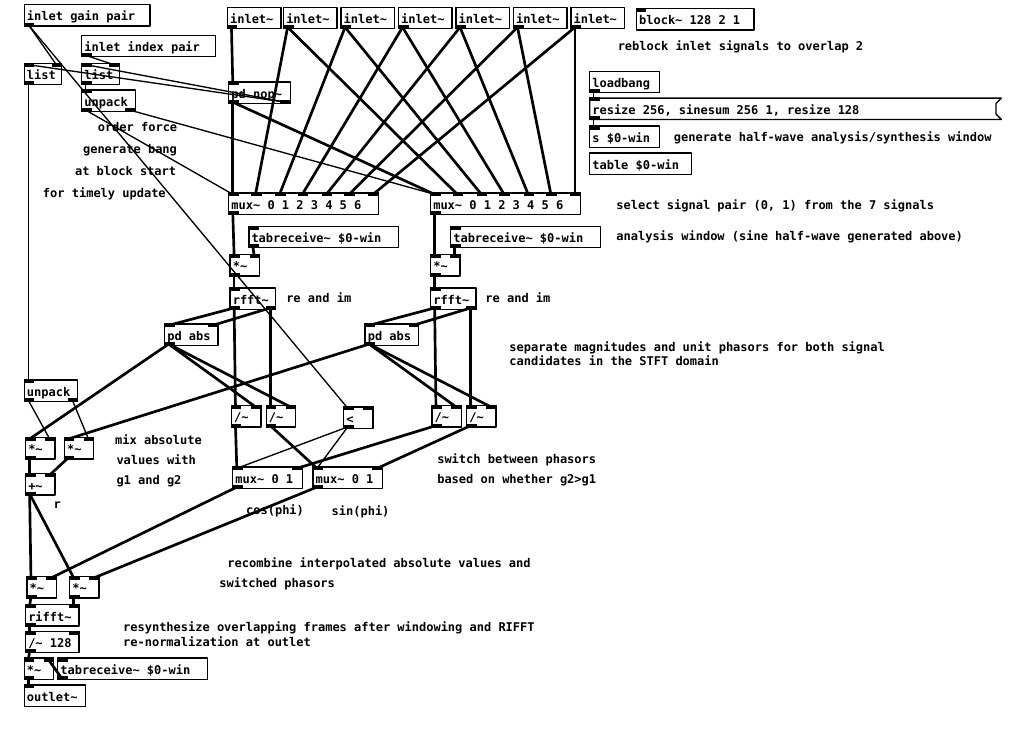
Figure A1. Implementation of the high-frequency patch in